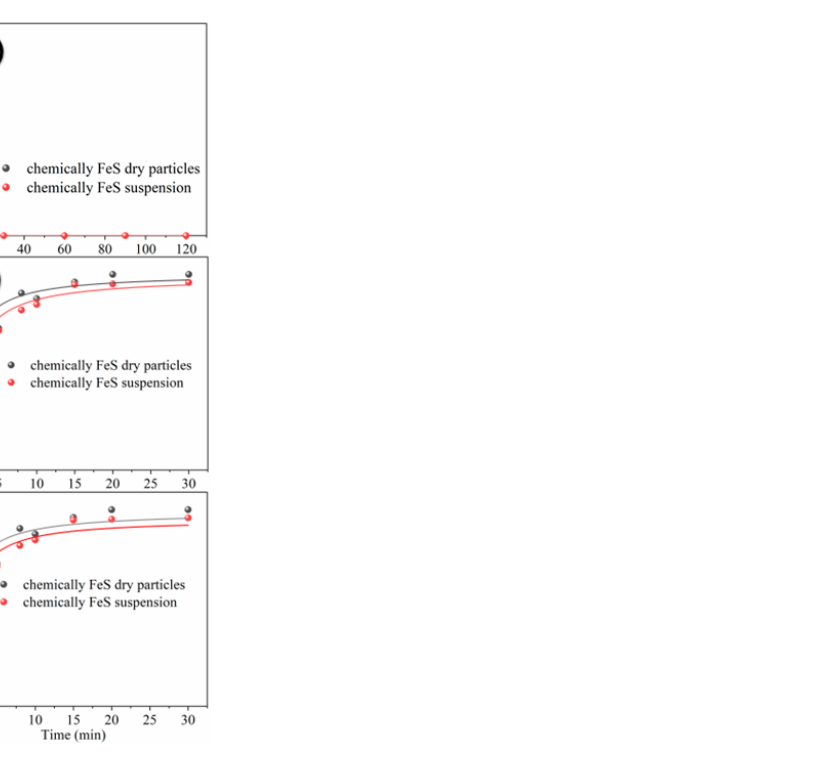
Figure 6. ( a , b ): Removal effect and reaction kinetics of Cr(VI) by suspension and dry particles of chemical synthesis FeS; ( c ): adsorption kinetic models of Cr(VI). Reaction conditions: FeS dosage concentration was 11.4 mM; Cr(VI) dosage concentration was 1.14 mM; initial pH was 5.0; reaction time was 2 h; and speed was 200 rpm. Data were plotted as means of duplicates, and the error bars indicate the standard deviation. Table 3. Kinetic parameters of chemical synthesis FeS suspension and dry particles for Cr(VI) removal and adsorption.